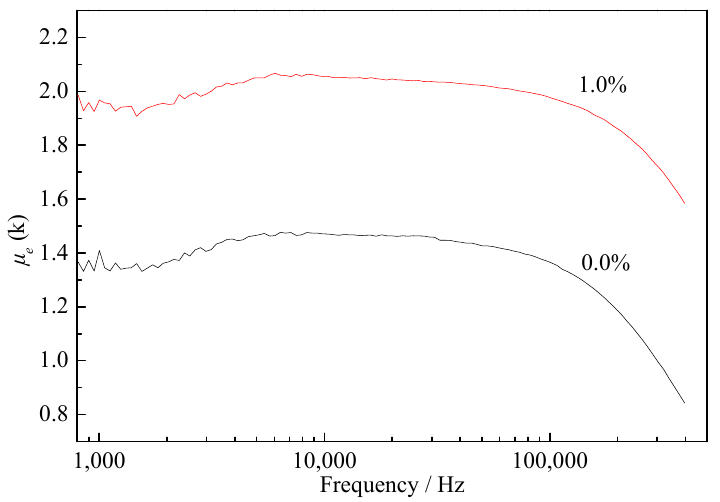
Figure 9. Comparison of frequency curves of 0.0% alloy and 1.0% alloy.